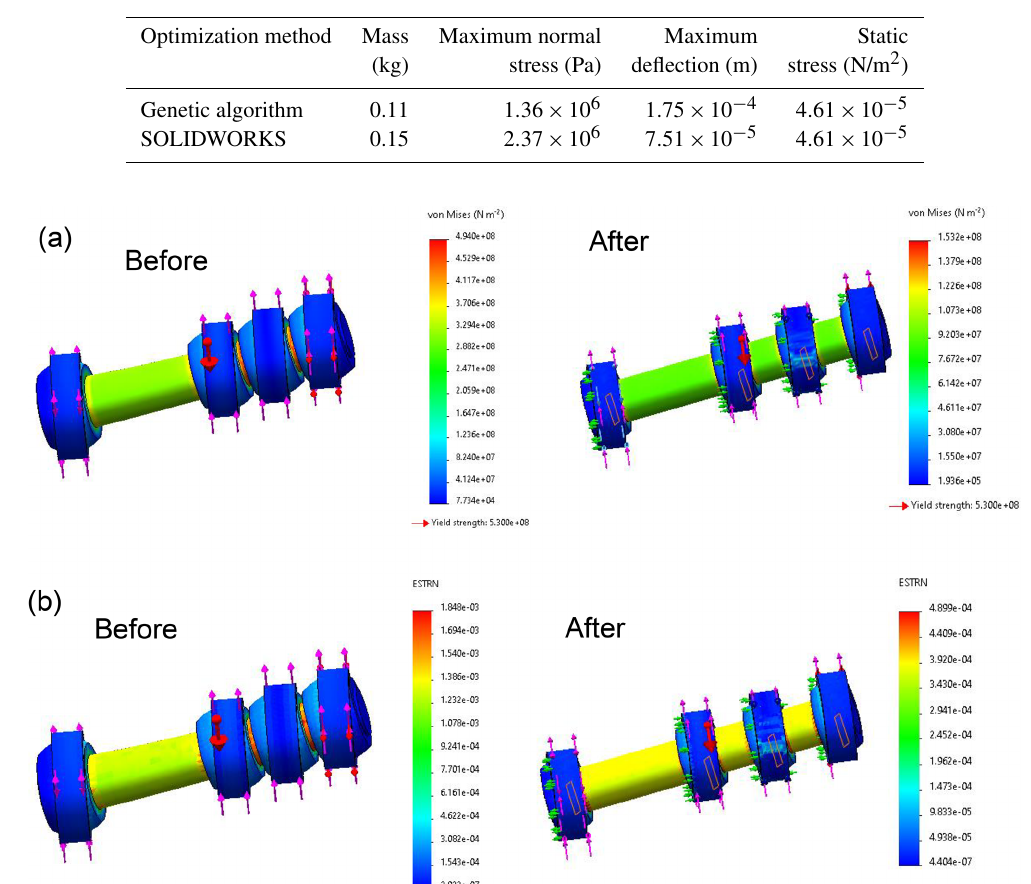
Table 4. Performance index obtained by the genetic algorithm and SOLIDWORKS simulation.